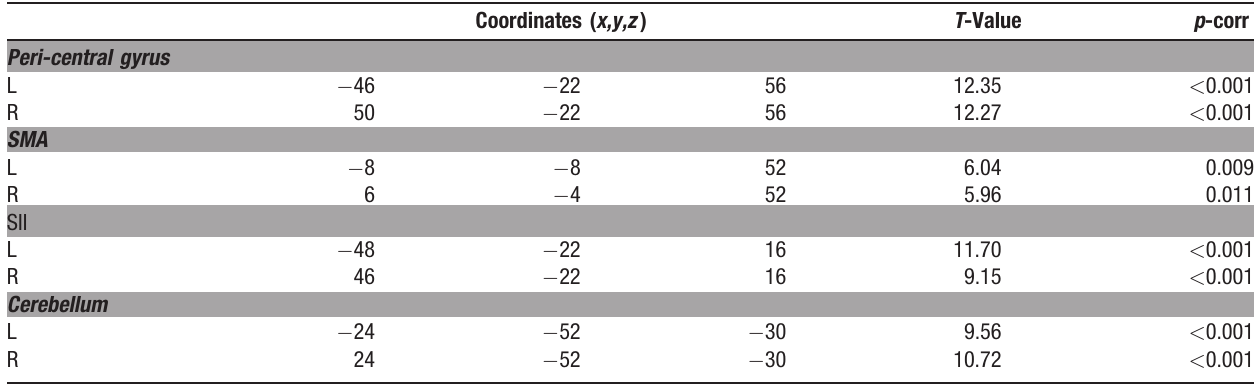
Anatomical location and statistical scores for the regions that activated during passive movement stimulation versus Rest. p-values are corrected for multiple comparisons, considering the whole brain as volume of interest. L/R, Left/Right hemisphere.